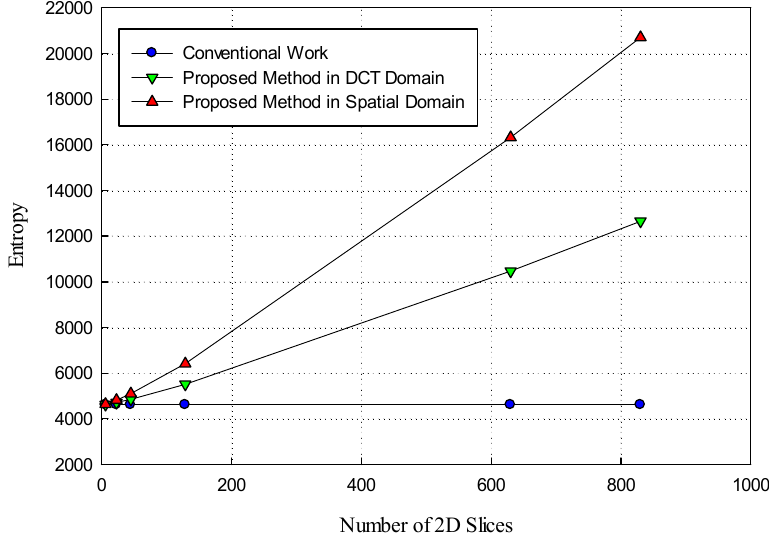
Figure 12. Entropy of the proposed methods according to the number of 2D slices.